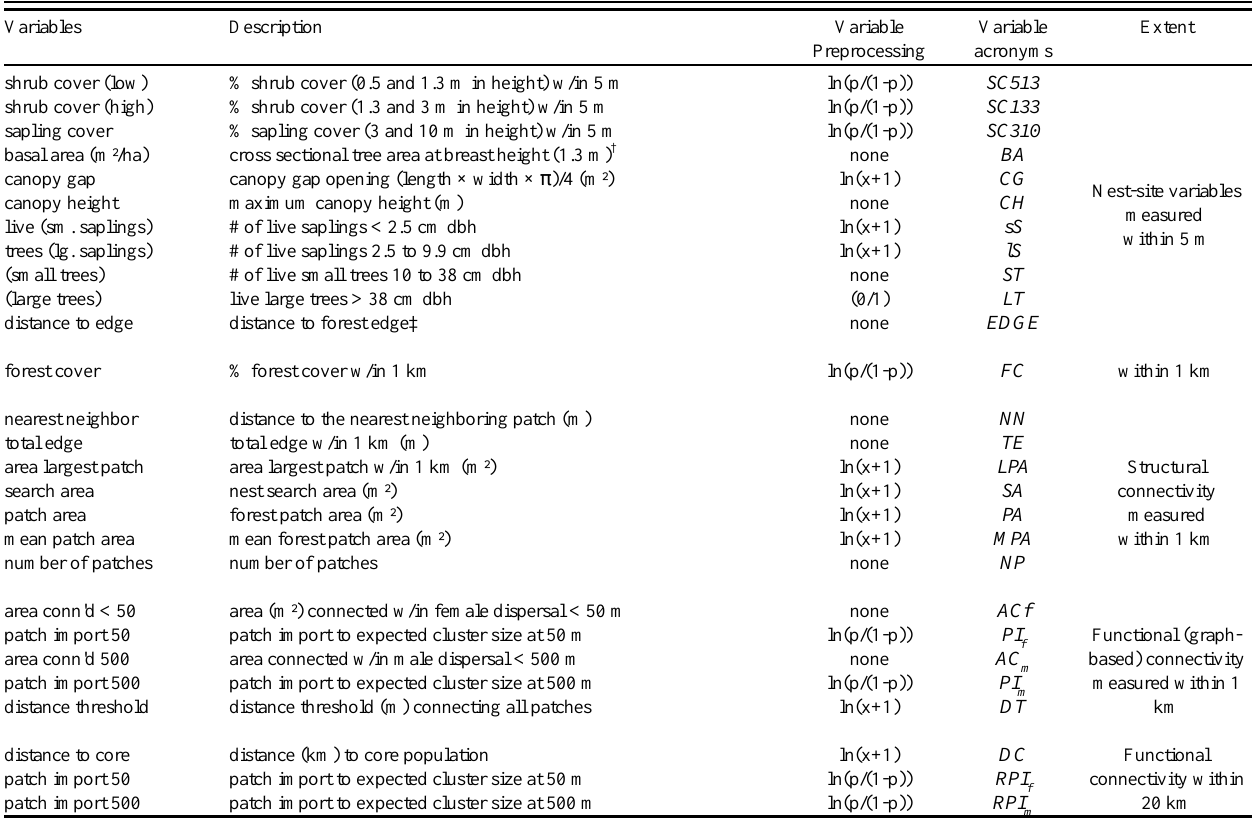
Table 1 . Variable codes and descriptions at different spatial extents for: nest-site vegetation characteristics, forest cover, structural and graph-based connectivity variables. (dbh = diameter at breast